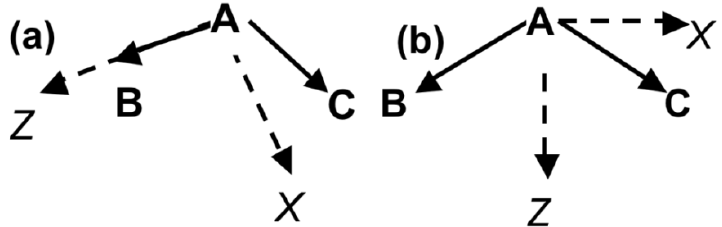
Figure 1. Local frame definition for the DMPG and POPS models. ( a ) Local frame definition of Z -then- X , where the first bonded atom defines the Z -axis, and the second bonded atom defines the ZX -plane and the positive X -direction; ( b ) local frame definition of Bisector, where the bisector of two neighboring atom defines the Z -axis.